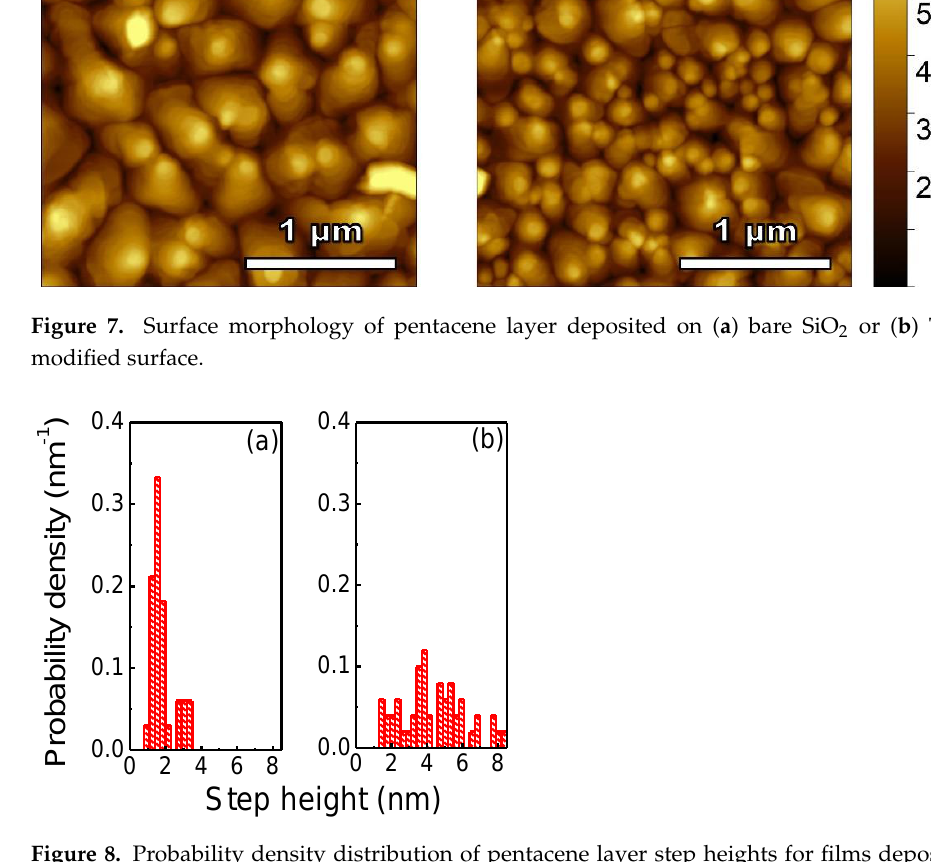
Figure 8. Probability density distribution of pentacene layer step heights for films deposited on ( a ) bare SiO 2 or ( b ) TTC11P modified surface.